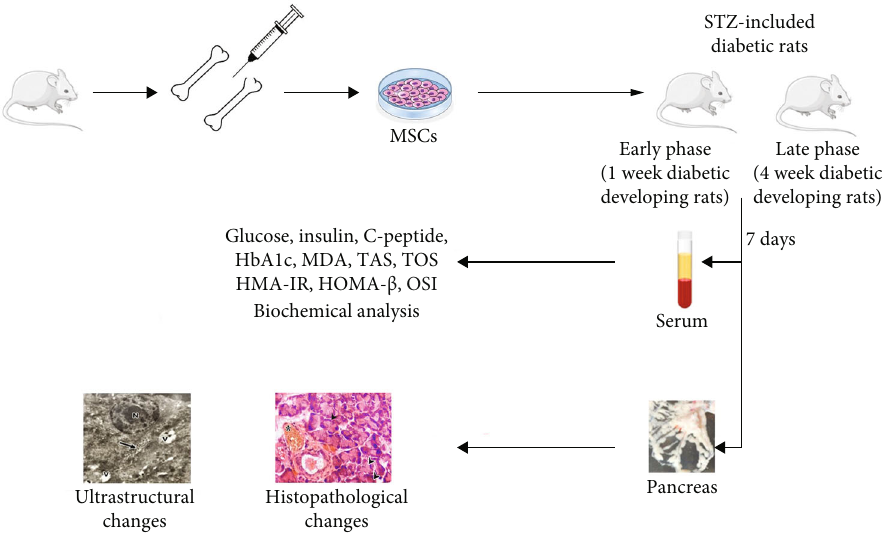
Figure 1: The isolation of MSC and the schematic representation of the study